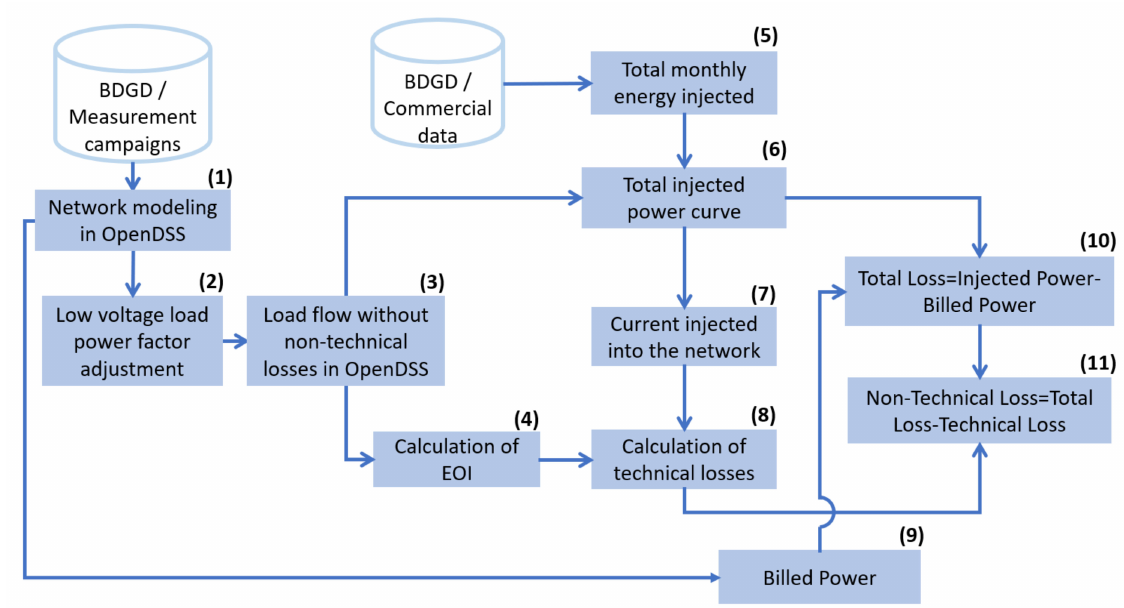
Figure 5. Flowchart of the load power factor adjustment